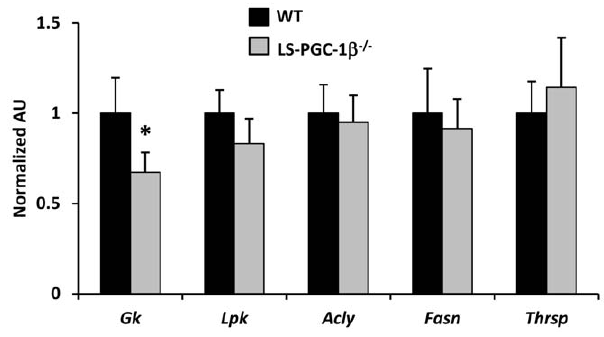
Figure 4. Basal expression of glycolytic and lipogenic genes is normal in LS-PGC-1 b 2 / 2 mice. The graphs depict the expression of glycolytic and lipogenic gene expression in WT and LS-PGC-1 b 2 / 2 mice. *P , 0.05 versus WT